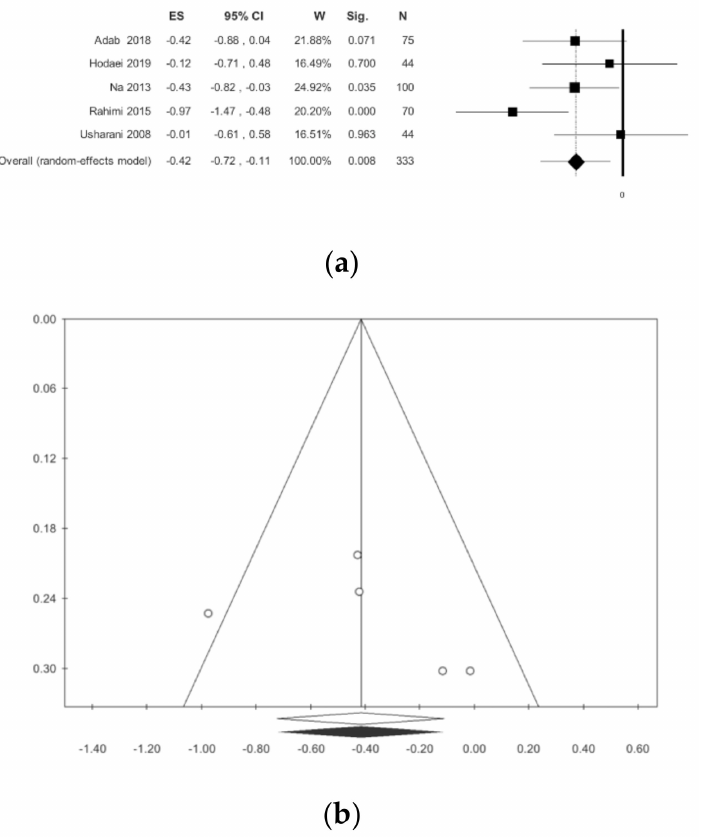
Figure 3. Meta-analysis results according to glycosylated hemoglobin (Hb1Ac): ( a ) forest plot ( b ) funnel